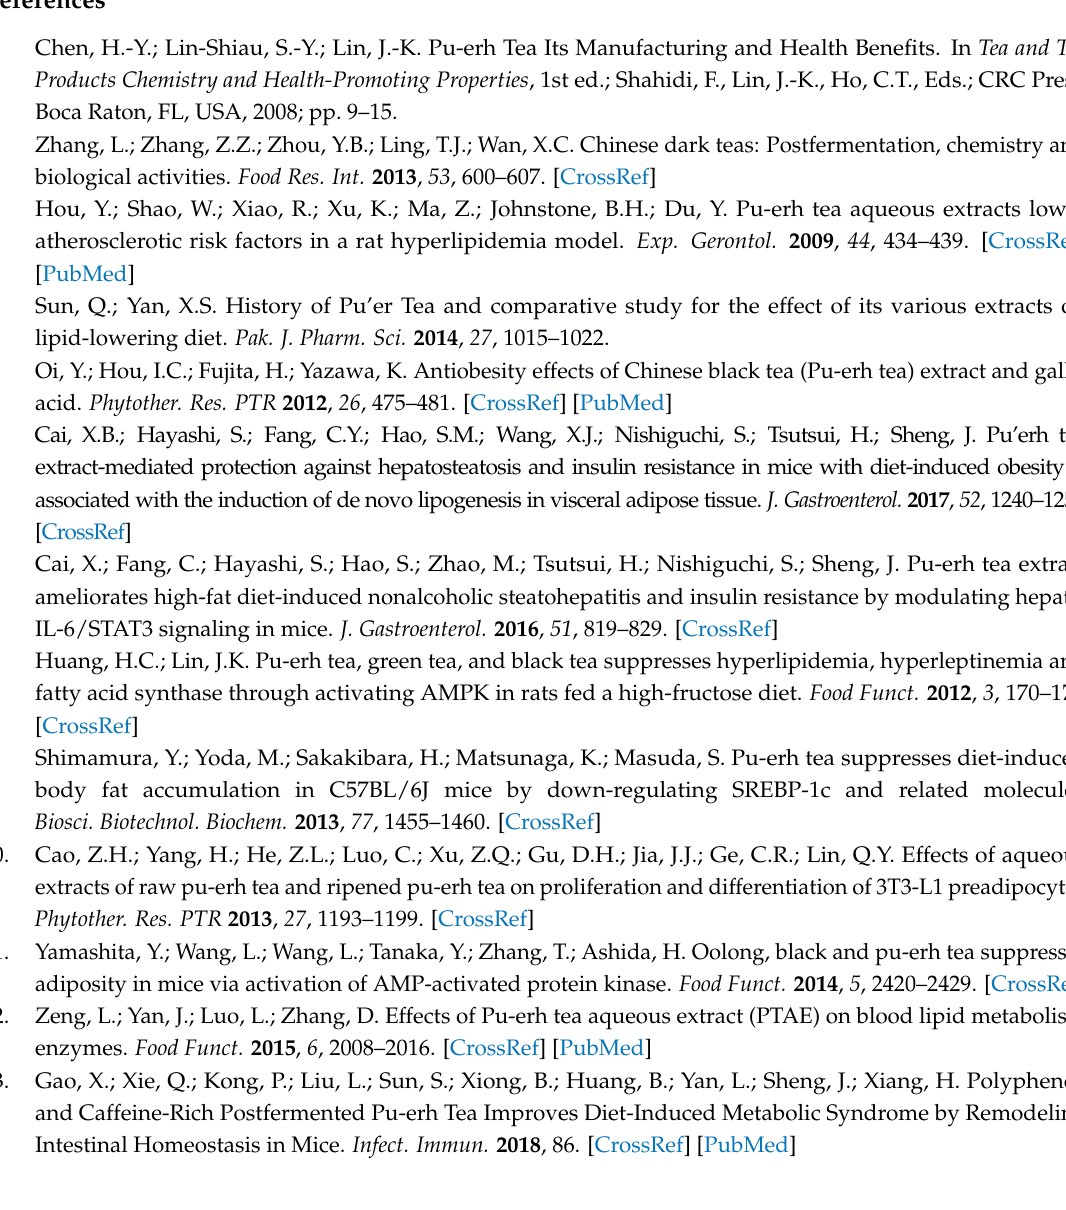
Supplementary Materials: The following are available online, Table S1: Identification of main chromatographic peaks in Figure 1, Table S2: Main parameters measured for water and hydro alcoholic extracts of ripe and raw pu-erh, Table S3: Effect of sonication on the antioxidant capacity of hydro alcoholic extracts of ripe and raw pu-erh. Author Contributions: Design of the work: G.R., C.P., G.A., M.C., Data acquisition: C.M., A.G., C.P.; Data